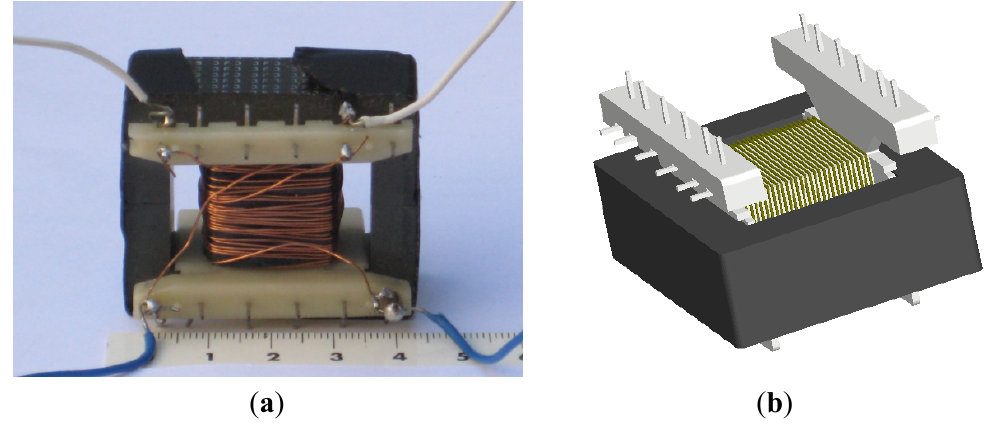
Figure 4. ( a ) Real transformer with E47/20/16 core and two windings of 28 turns; ( b ) E47/20/16 geometry used in the 3D simulations.